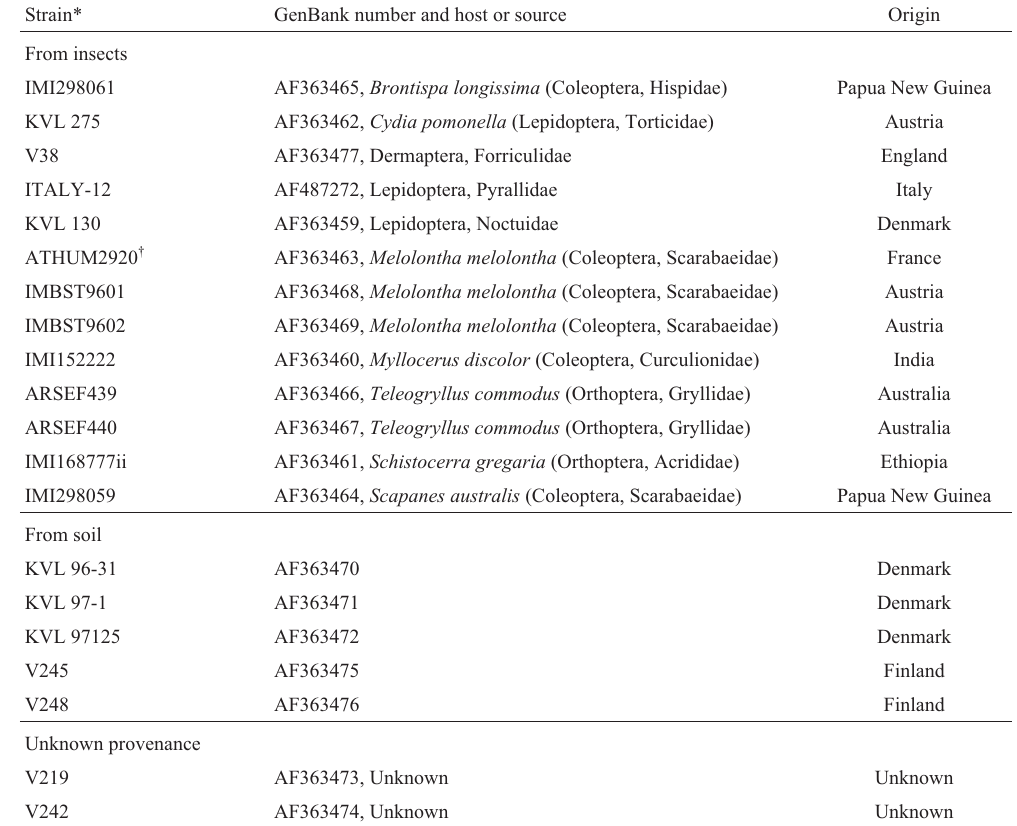
Table 2 - The rDNA intergenic spacer rDNA sequences of Metarhizium anisopliae var. anisopliae isolates retrieved from GenBank, with their hosts and geographic origins.